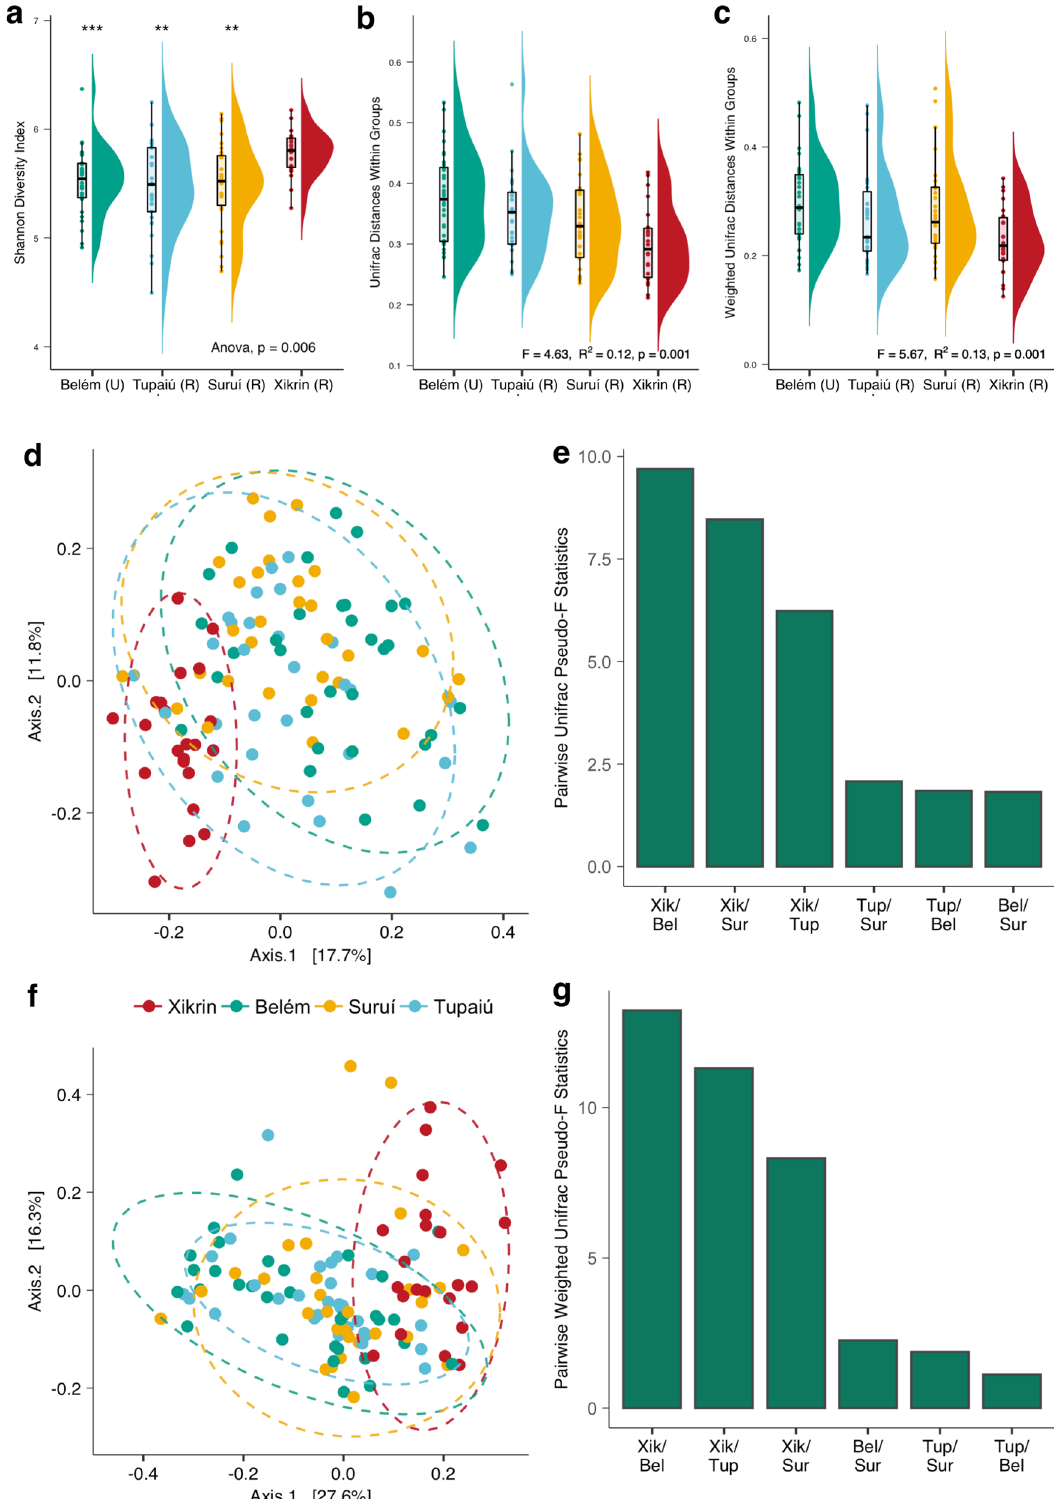
Fig. 2 Within- and between-group diversity measures. a Shannon index. b Unweighted Unifrac distances within groups. c Weighted Unifrac distances within groups. d PCoA of unweighted Unifrac distances. e Weighted Unifrac pairwise PERMANOVA differences among population pairs. f PCoA of weighted Unifrac distances. g Unweighted Unifrac pairwise PERMANOVA differences among population pairs. NS not signi fi cant, * p ≤ 0.05, ** p ≤ 0.01, *** p ≤ 0.001, **** p ≤